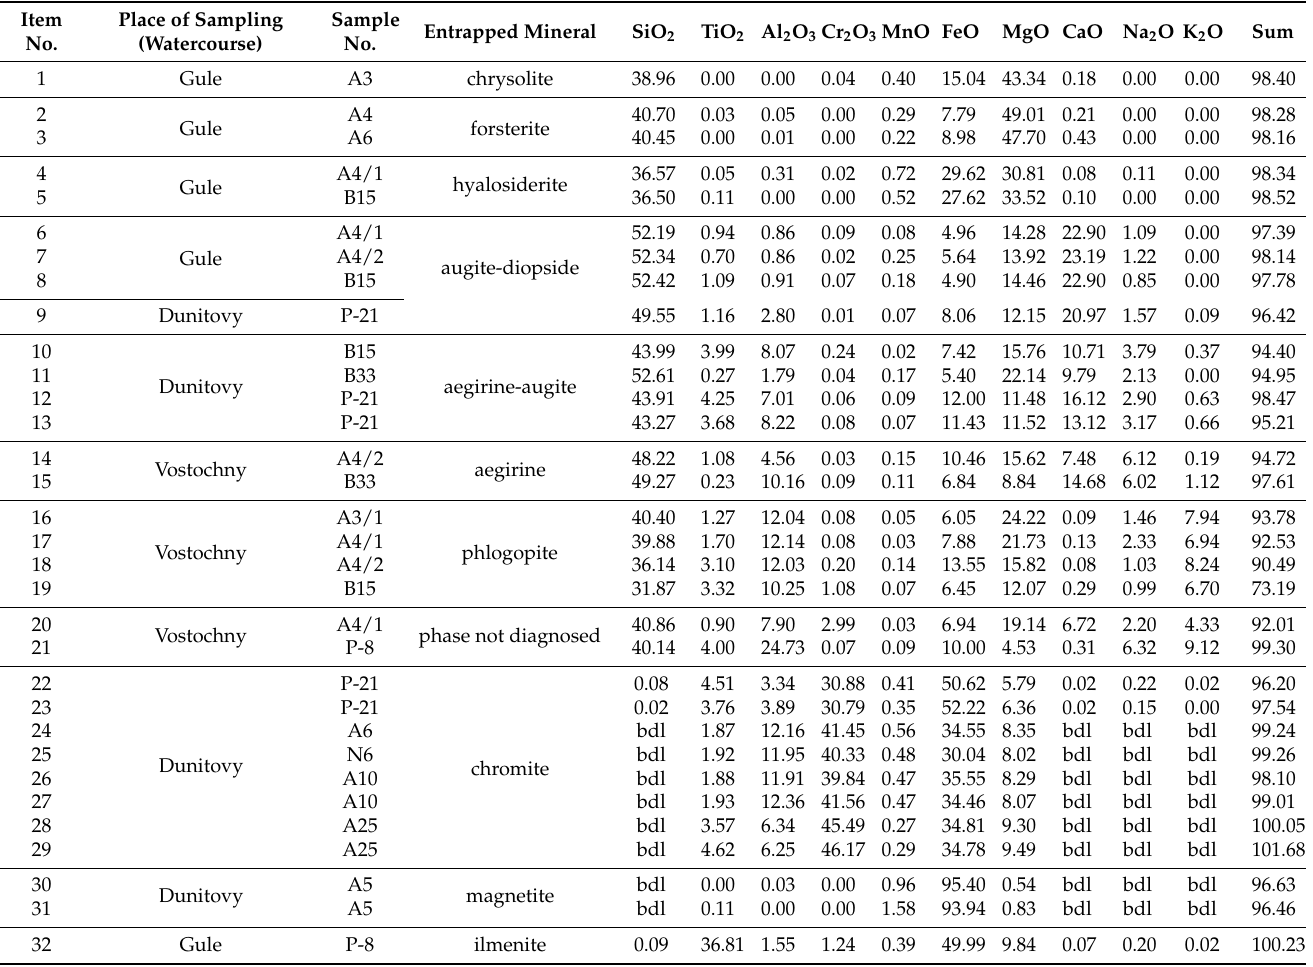
The association: native osmium ± isoferroplatinum ± ir-osmium ± irarsite + aegirine ± ilmenite ± alkali feldspars ± erlichmanite ± chalcopyrite corresponds to the fifth phase of magmatism, the formation of nepheline and alkaline syenite bodies. Table 4. Chemical composition of the minerals entrapped in native osmium, wt. %.